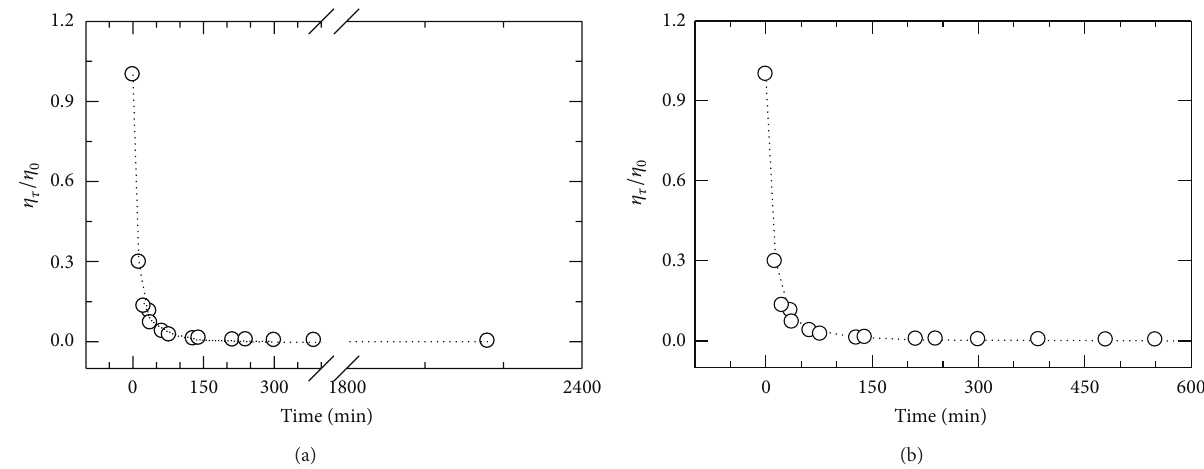
Figure 2: (a) The normalized solution viscosity, 𝜂 𝜏 /𝜂 0 , as a function of reaction time (0–2400 min) for fragmentation of chitosan solution (1.0% w/v) by 0.5N HCl. Open circle for experimental point and dotted line for curve fit; (b) the normalized solution viscosity, 𝜂 𝜏 /𝜂 0 , as a function of reaction time (0–300min) for fragmentation of chitosan solution (1.0% w/v) by 0.5 N HCl. Open circle for experimental point and dotted line for curve fit. The reaction was performed at 65 ∘ C, and solution viscosity was measured at 25 ∘ C.